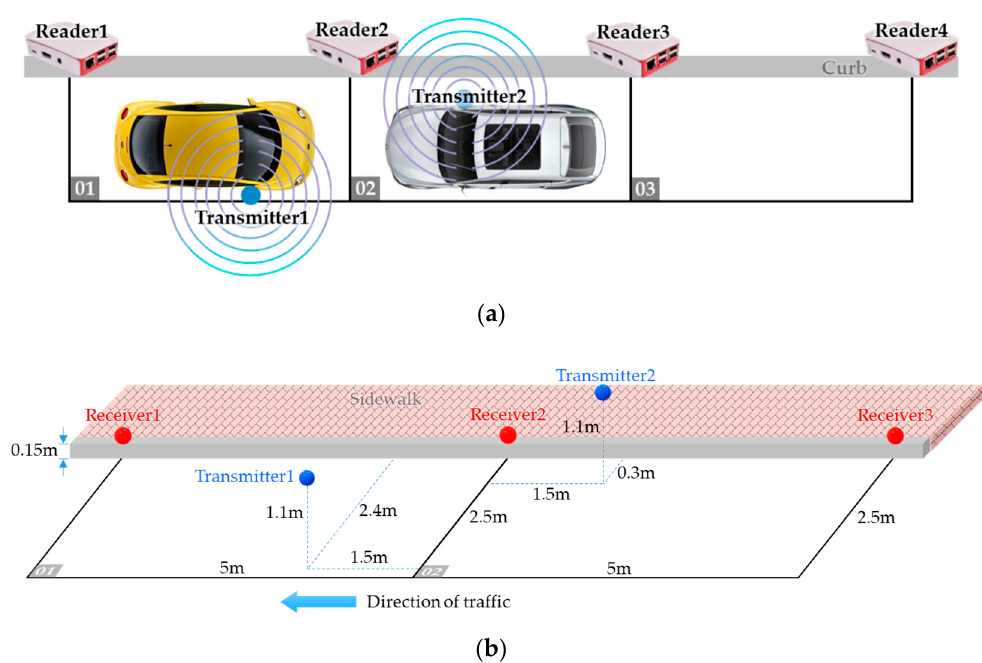
Figure 13. Experiment 3: ( a ) test scenario, ( b ) detailed deployment within parking space 01 and 02.